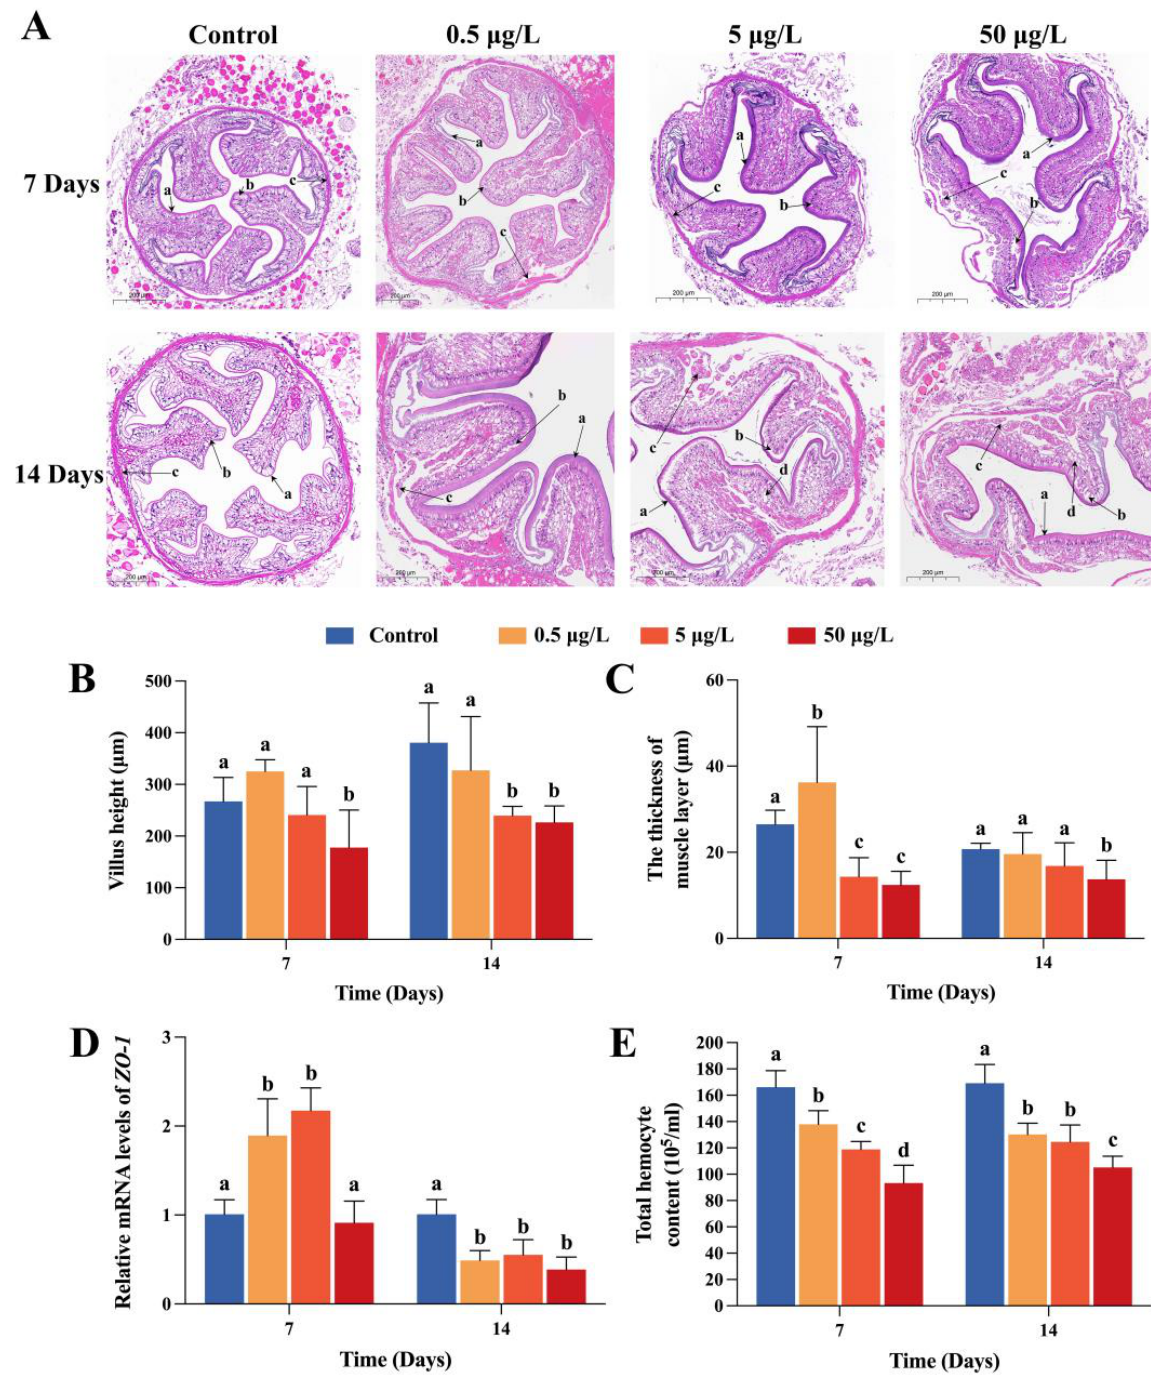
Figure 1. FF-induced intestinal damages in Chinese mitten crab. ( A ). Intestinal histological variation taken by hematoxylin-eosin assay. Magnification is 200 × and the scale bar is 200 µ m. Letters in the figure represent (a) intestinal peritrophic membrane; (b) epithelial cells; and (c) muscle layer; (d) vacuole. ( B ) Villus height. ( C ) The thickness of muscle layer. ( D ) mRNA levels of ZO-1 . ( E ) Total hemocyte content. Data was analyzed based on six separate samples and presented as the mean ± SEM. Here and hereafter, different letters (a, b, c, d) indicate significant difference among control and three FF exposed groups ( p < 0.05).